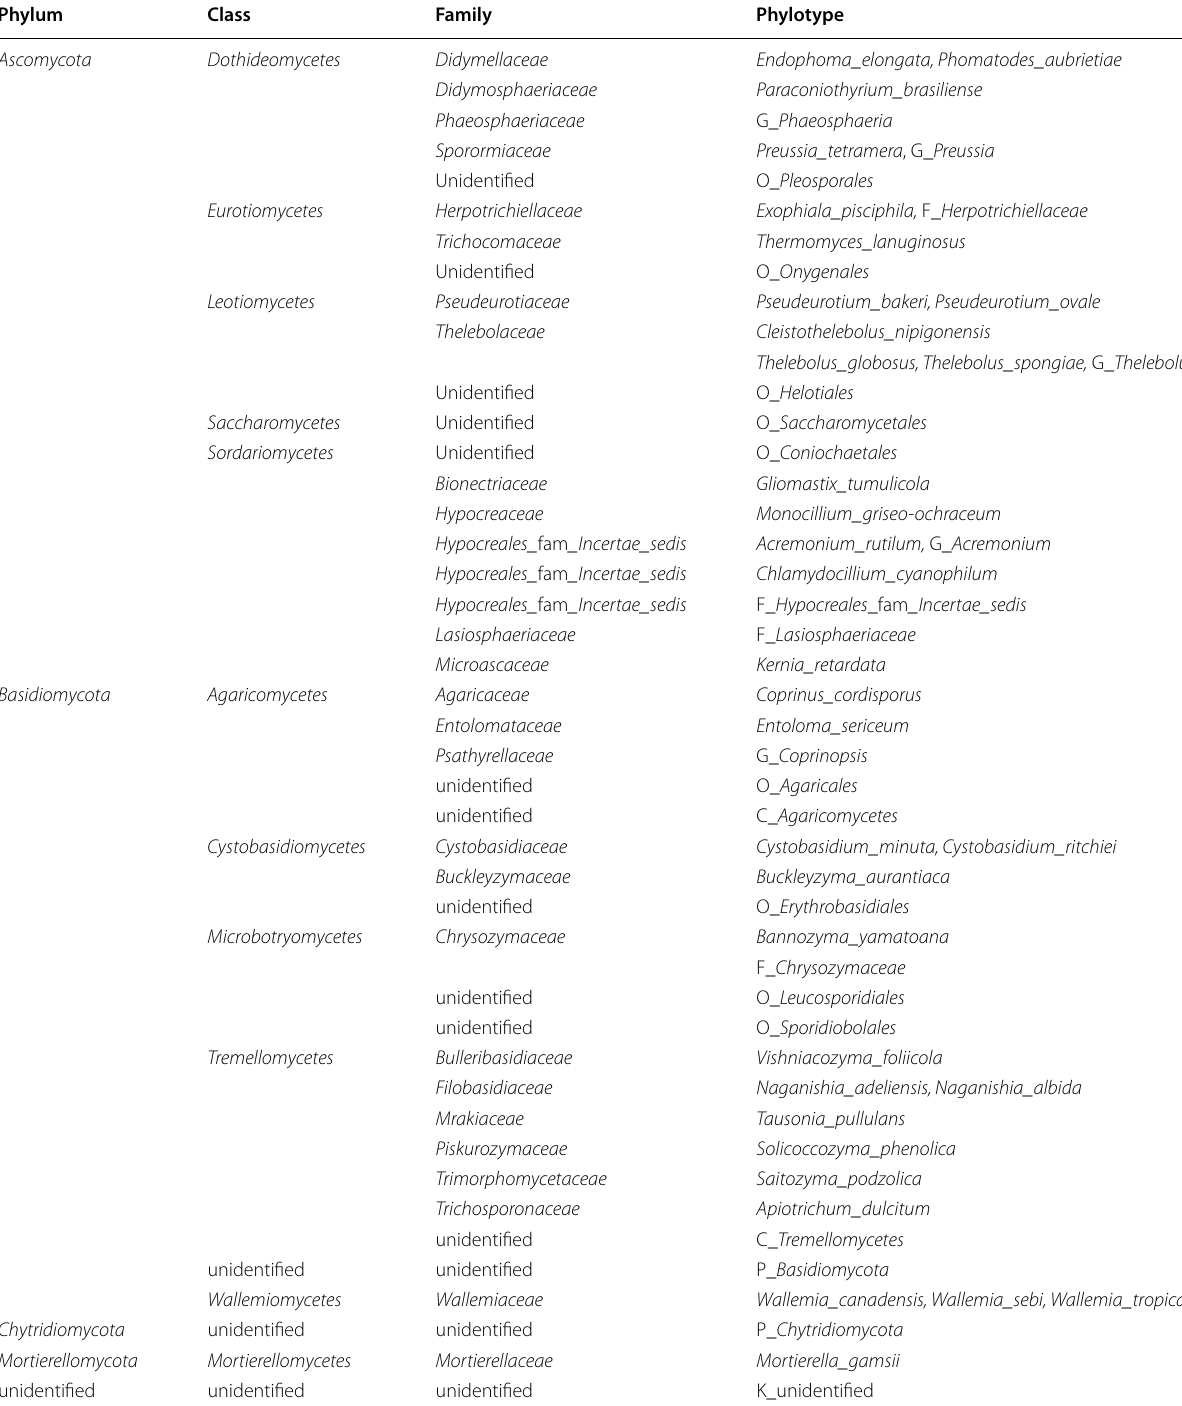
Table 2 List of 56 key phylotypes that were associated with EGS